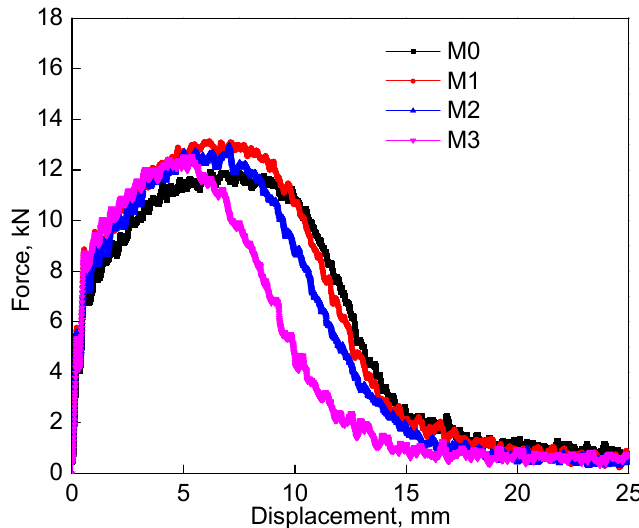
Figure 5. Force–displacement curves of impact specimens with different Mo additions.